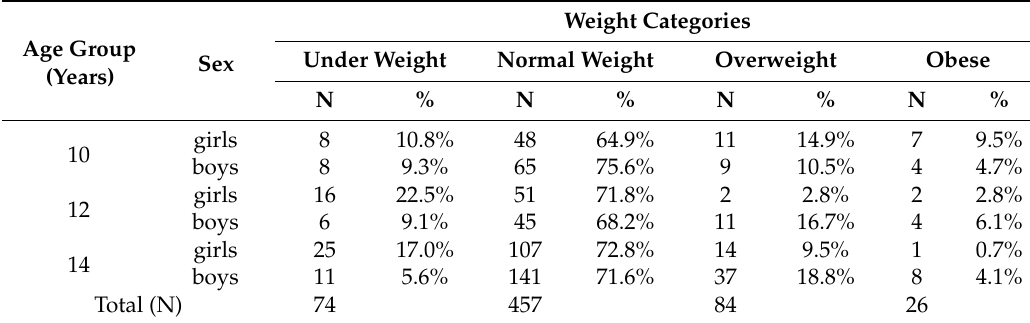
Table 2. Descriptive statistics for weight categories.